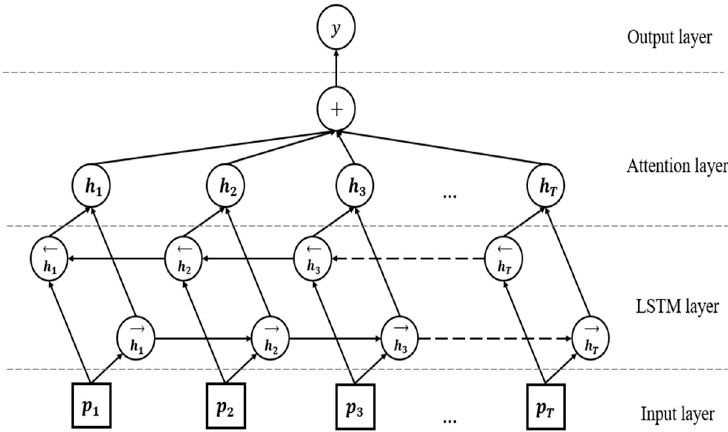
Figure 5. Bidirectional LSTM model with attention.